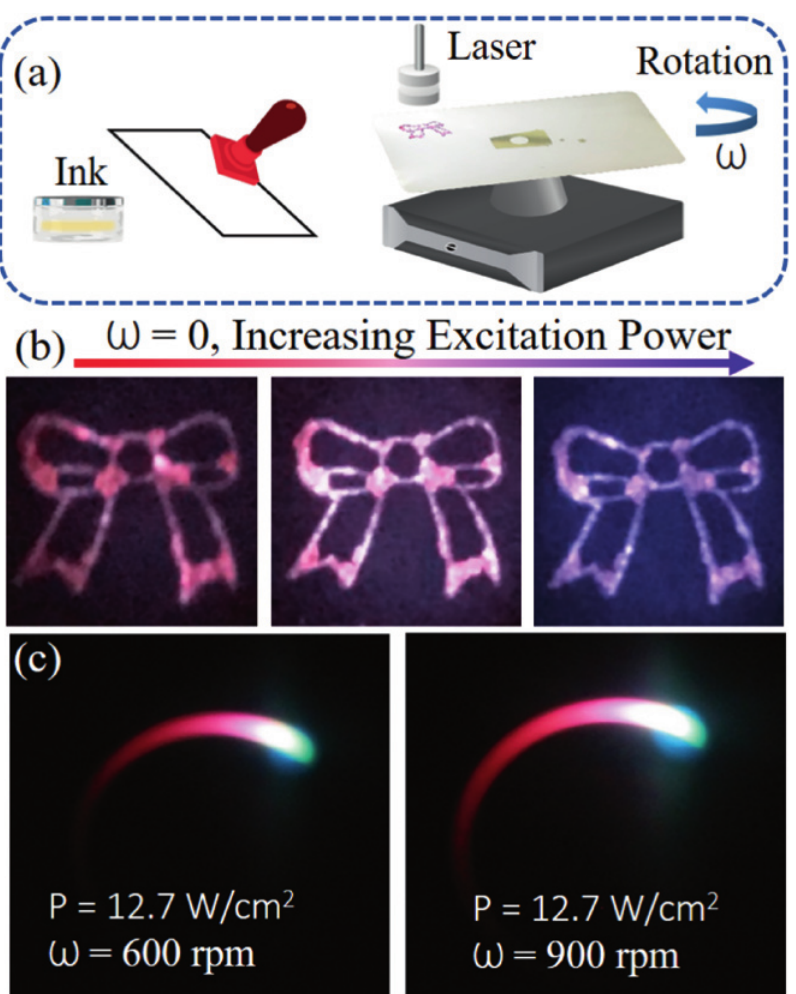
Figure 6: (a) Schematic illustration of the anti-counterfeiting process. (b) Digital photographs of the designed patterns with increasing excitation power density from 5 to 11 W/cm 2 . (c) Digital photographs of the designed patterns at different rotating